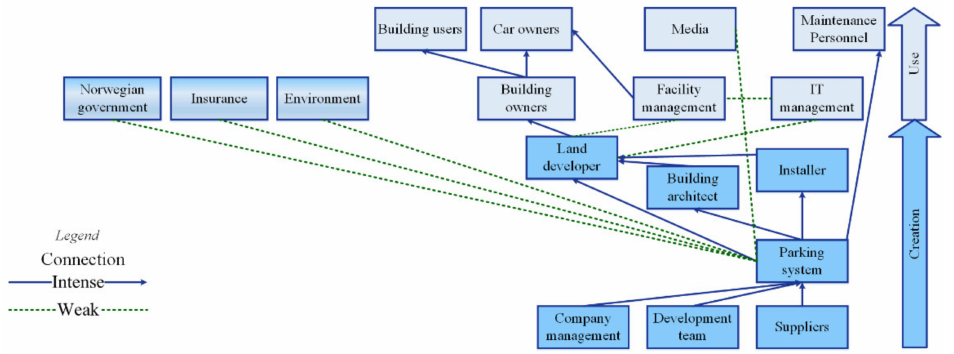
Figure 22. Value